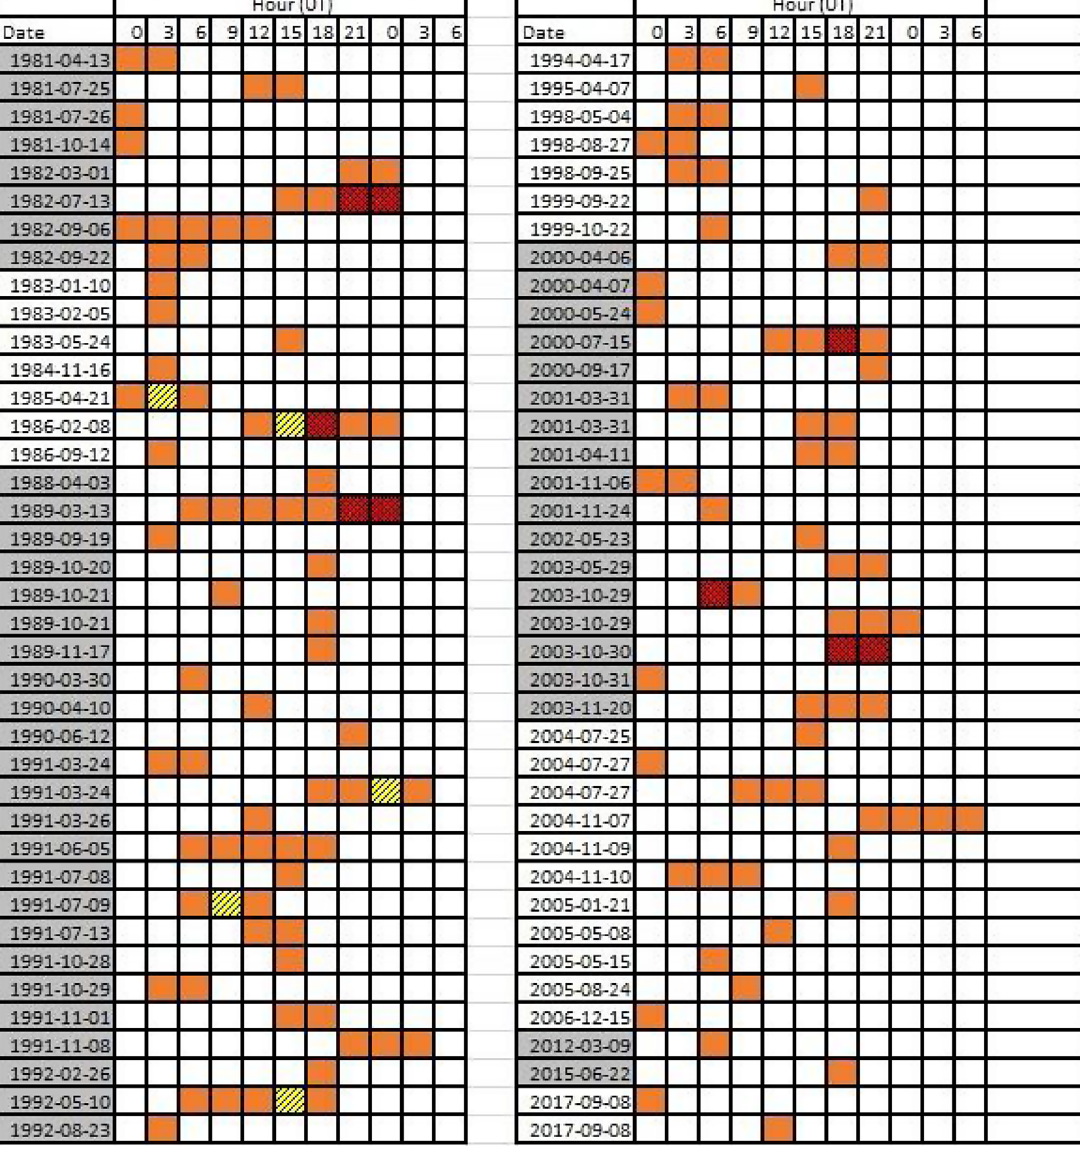
Fig. 4. Date and time (in UT-hour) of MOD and SEV level AA based on Kp-index. Each block represents a 3-h period. Orange (solid) and red (crosshatched) shading indicate MOD and SEV level activity. Yellow (diagonal striped) shading indicates a 3-h gap in MOD or SEV activity observed during an event. Each line represents a different event. Grey shading indicates events observed during solar maximum years, similar to Figure